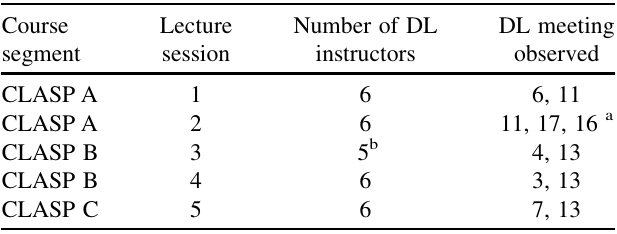
TABLE II. Course and observation breakdown.